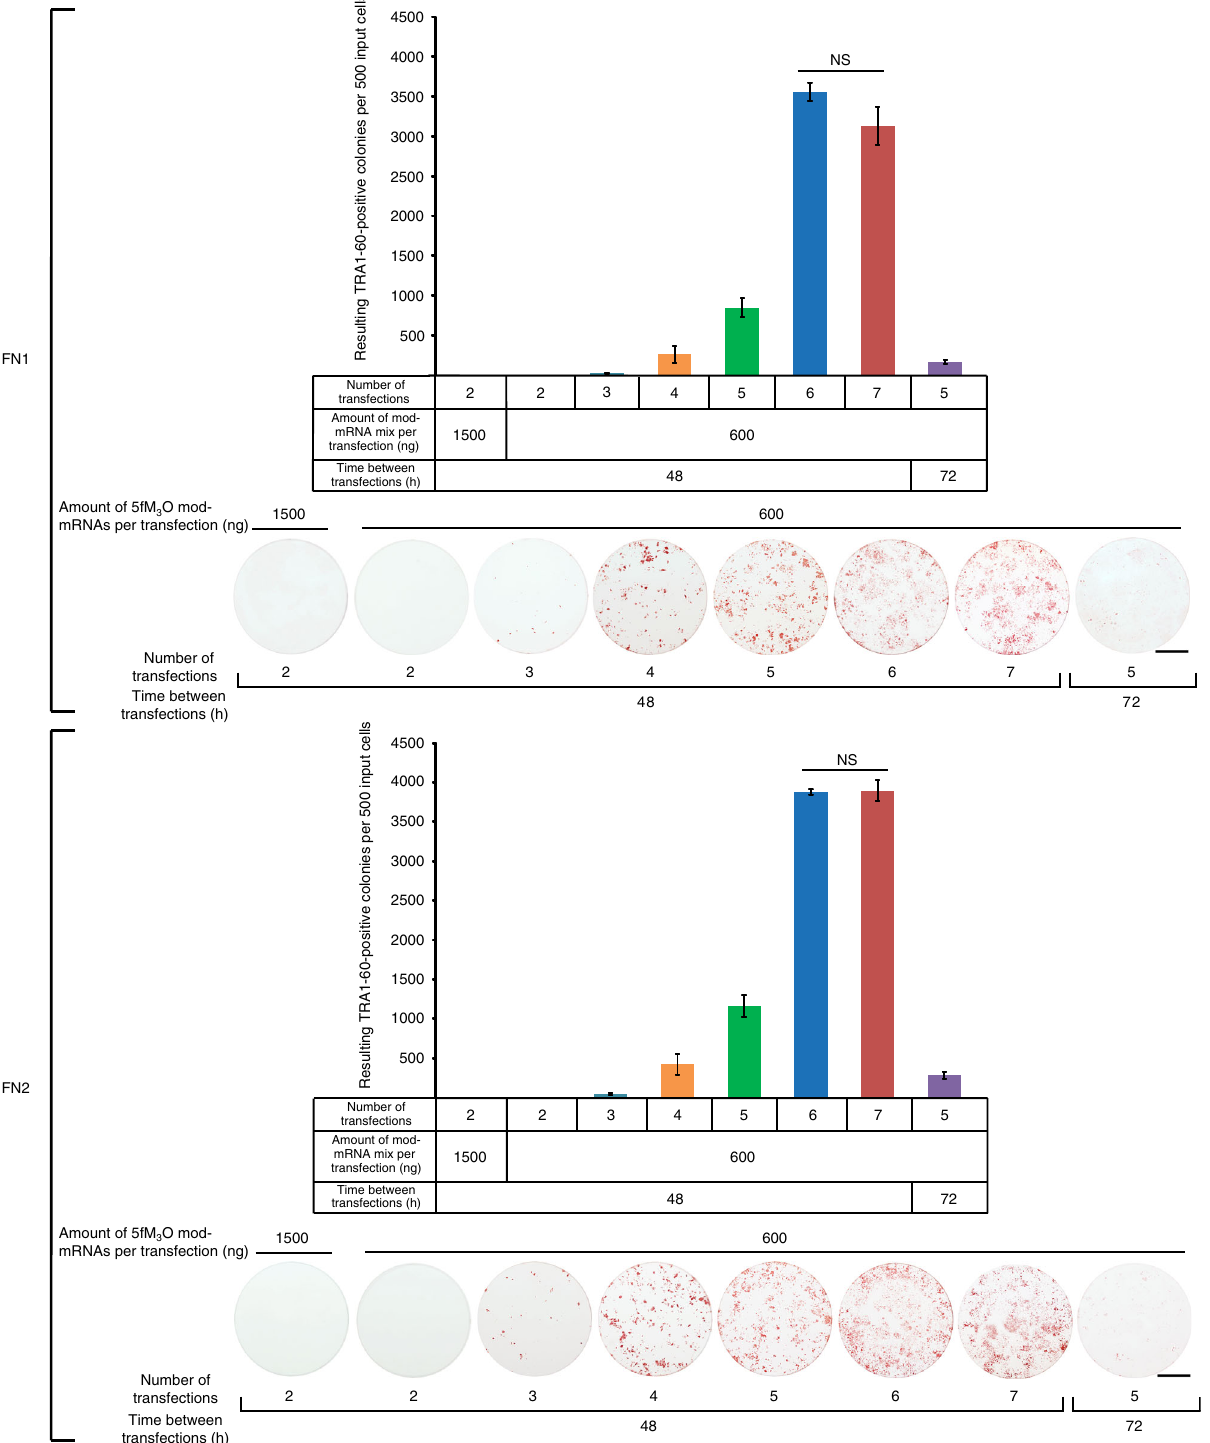
Fig. 2 De fi ning the minimal and the optimal number of RNA transfections for the RNA-based reprogramming approach. Summary plots and representative TRA-1-60-stained reprogramming wells show the yield of TRA-1-60-positive colonies at day 18 of reprogramming initiated at a plating density of 500 cells per well of a 6-well format dish with two independent human primary neonatal fi broblast lines, FN1 (top) and FN2 (bottom). The reprogramming was accomplished using the indicated numbers of mod-mRNA and m-miRNA transfections performed at either 48 or 72 h intervals using Opti-MEM-8.2 as the transfection buffer. The amount of m-miRNA used per transfection is 20 pmol, and the amount of mod-mRNAs is indicated. Error bars, mean ± s.d. ( n = 3). No statistical difference in the reprogramming ef fi ciencies was observed between 6 and 7 transfections (NS, P > 0.05). P values were calculated using the unpaired two-tailed Student ’ s t test. Scale bars, 10